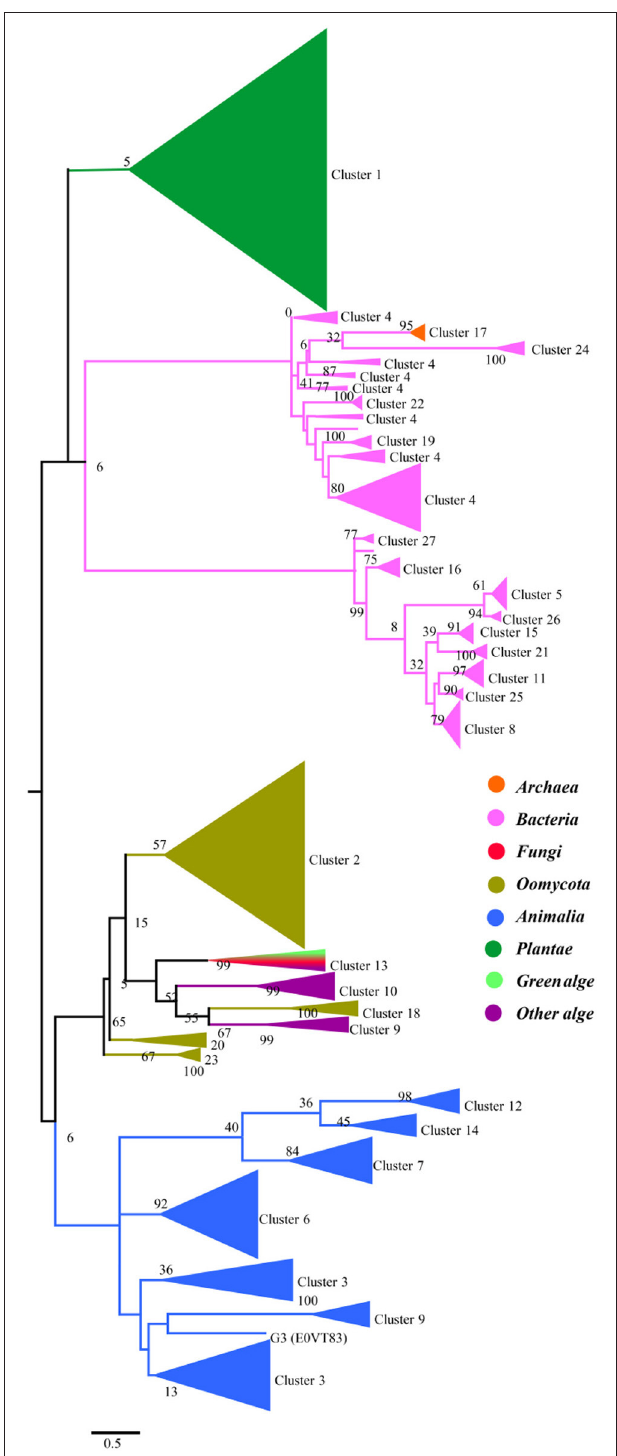
FIGURE 2 | Maximum likelihood phylogenetic tree for SWEETs and SemiSWEETs generated using MEGA. The tree with the highest log likelihood ( − 325820.9727) is shown. The percentage of replicate trees in which the associated taxa clustered together in the bootstrap test (1,000 replicates) is shown next to the branches. The color of each branch corresponds to the color of its cluster in Figure 1